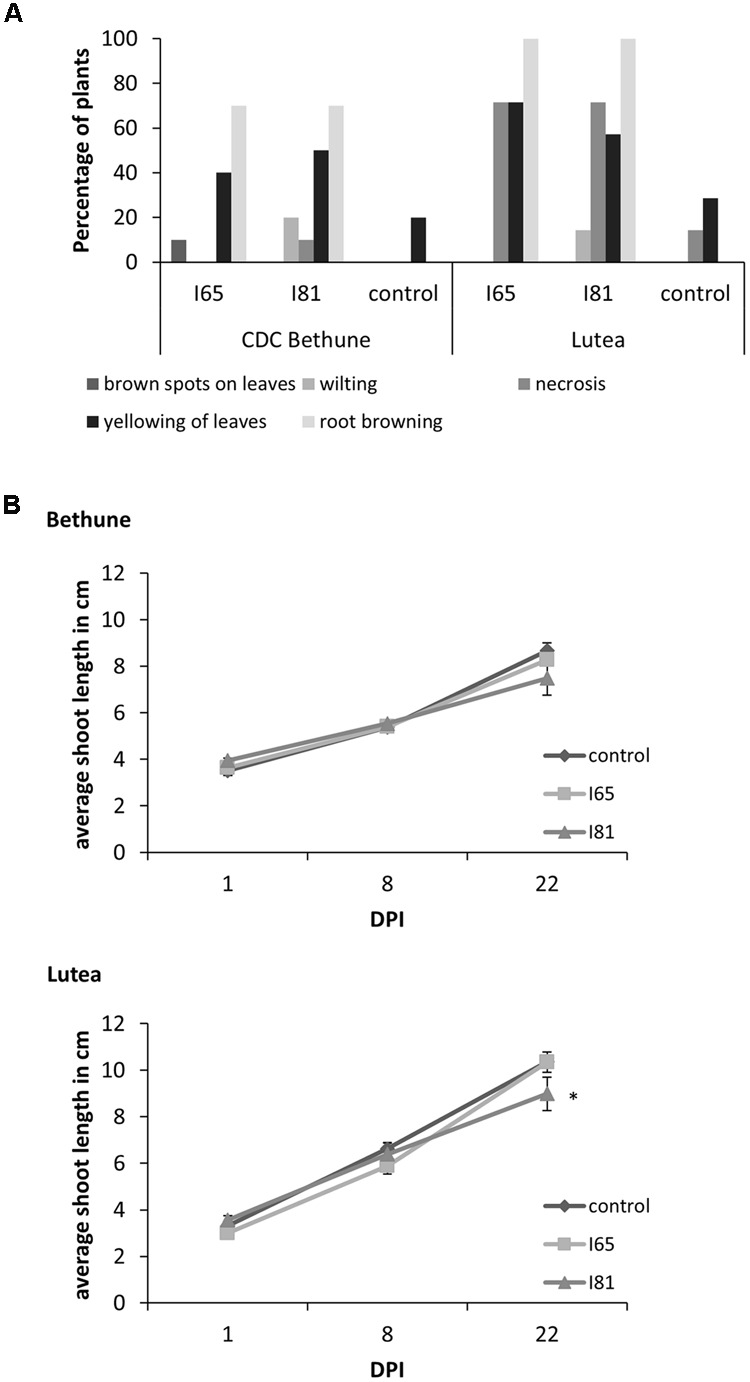
Disease symptoms and shoot length growth inhibition upon Foln infection. (A) Percentage of plants presenting disease symptoms 22 DPI in the flax cultivars CDC Bethune and Lutea due to the infection with isolates #65 and #81 (indicated as I65 and I81 on the figure) of Fusarium oxysporum f. sp. lini. (B) Difference in average shoot length between control plants and plants inoculated with isolates #65 and #81 for cultivars CDC Bethune and Lutea. An asterisk (∗) denotes a significant difference between the control plants and the isolate #81 Lutea plants at day 22 (one tail t-test, p = 0.04). Error bars = standard error; DPI = days post-inoculation.